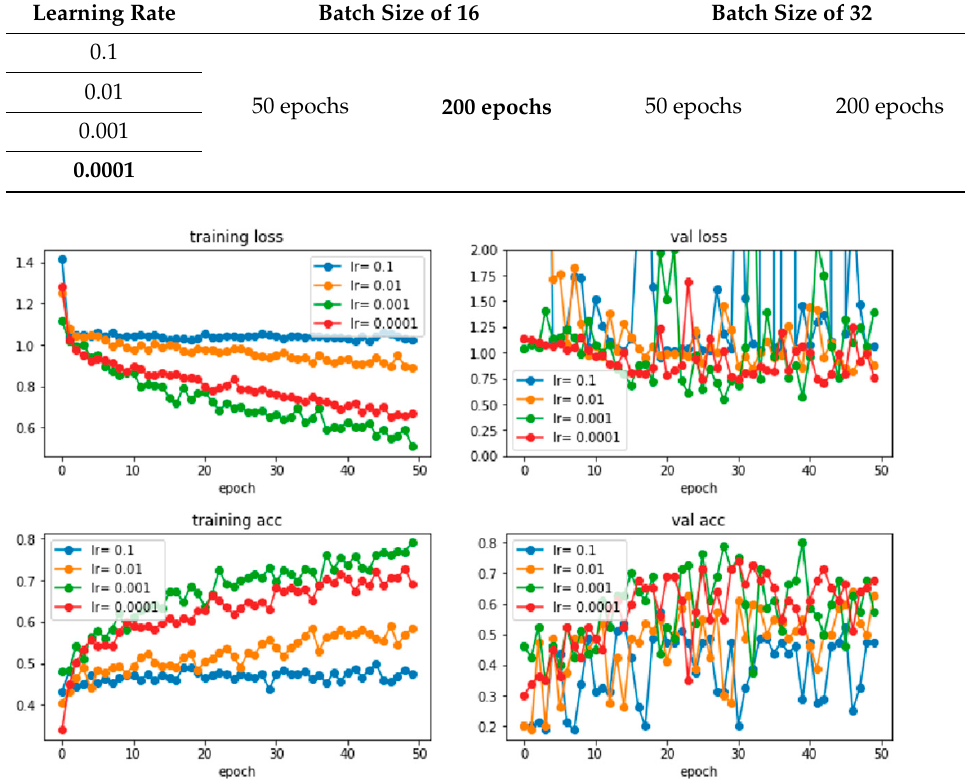
Figure 13. The training loss, validation loss, training accuracy, and validation accuracy of learning rates range from 0.0001 to 0.1 with 50 epochs and a batch size of 16.